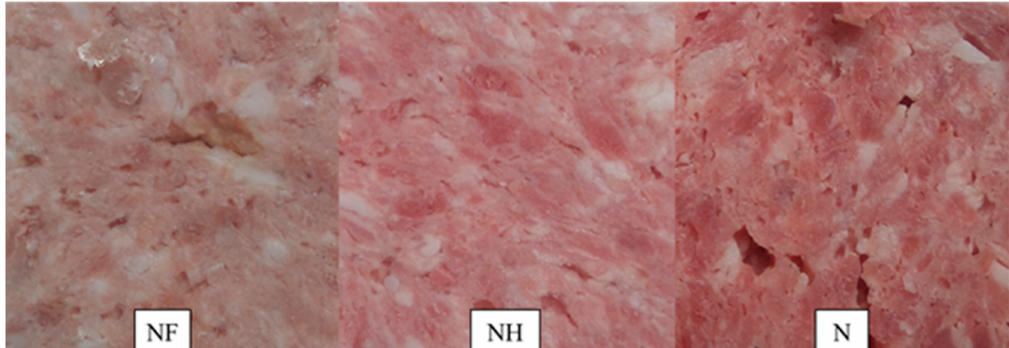
Figure 1. Visual aspects of canned meat with various amounts of nitrite after 180 days of storage.